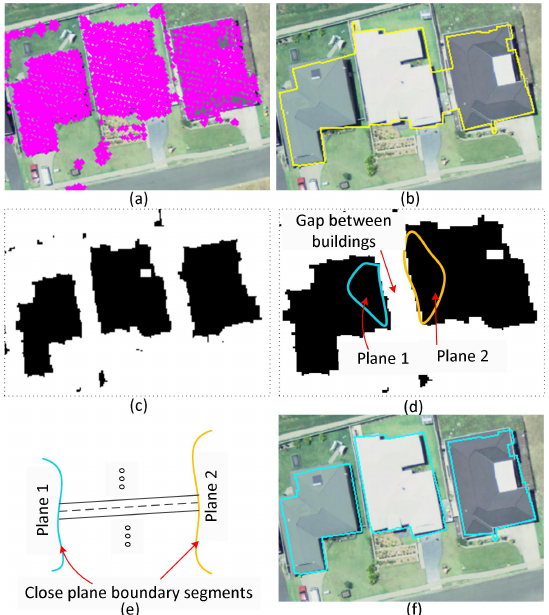
Figure 2: Separating nearby buildings: (a) input (non-ground) point cloud data, (b) extracted building footprint (buildings are merged), (c) corresponding building mask, (d) boundaries of two neighbouring roof planes, (e) close segments of plane boundaries (dashed line to test gap between planes) and (f) improved building footprints (buildings are